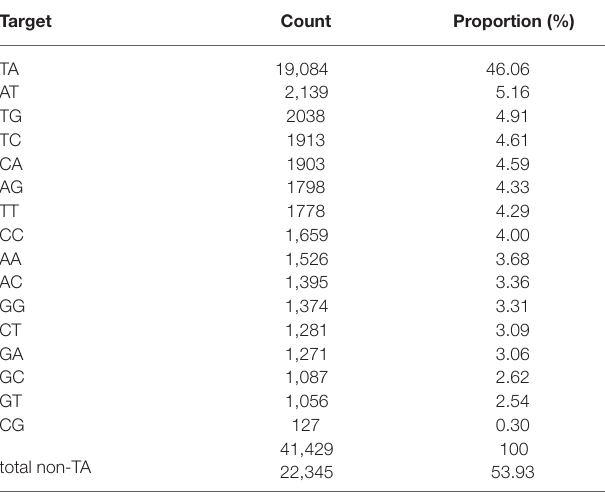
TABLE 3 | The non-TA integrations from one of the previous Sleeping Beauty (SB) mutagenesis study (Chen et al., 2016). Target Count Proportion (%) TA